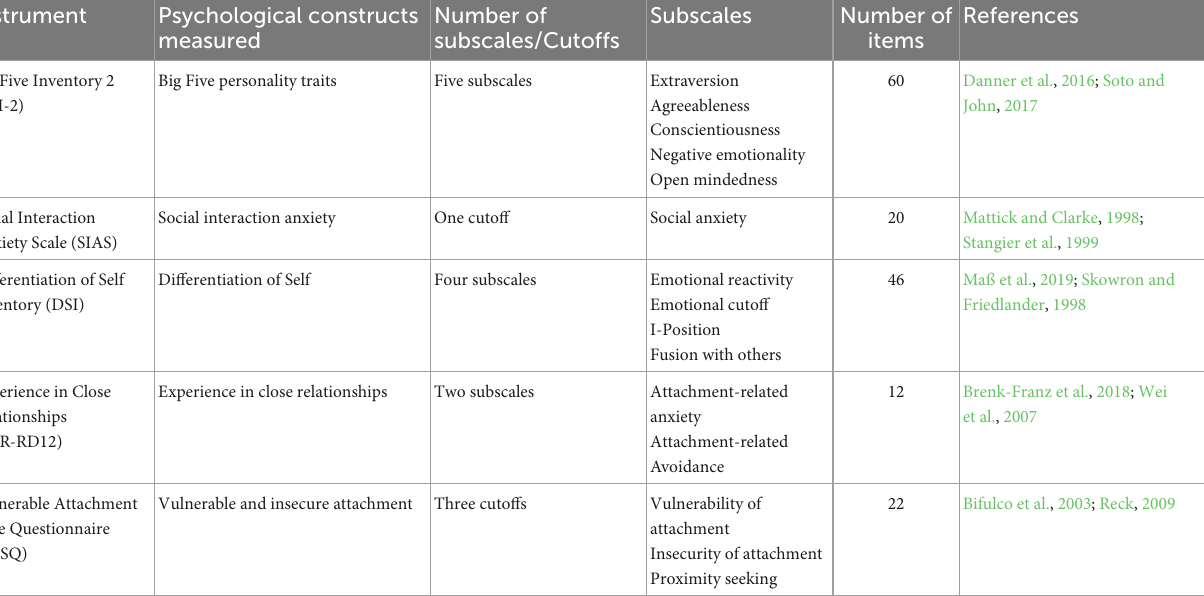
TABLE 1 Psychometric